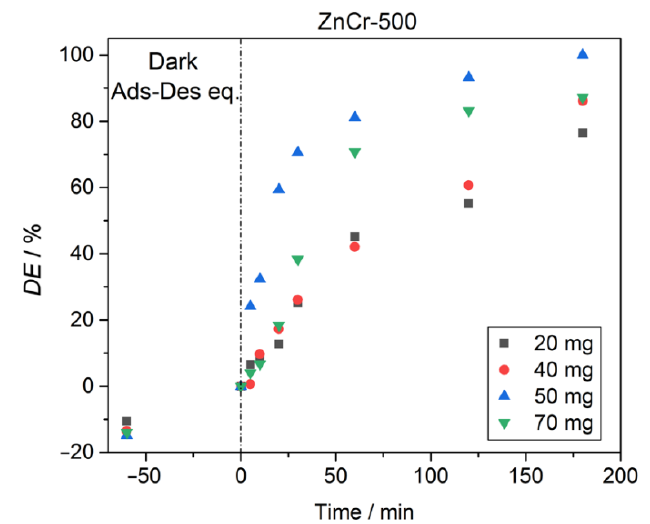
Figure 12. Effect of ZnCr-500 catalyst mass on degradation efficiency of CV (dye concentration 5 mg L − 1 , pH = 7).